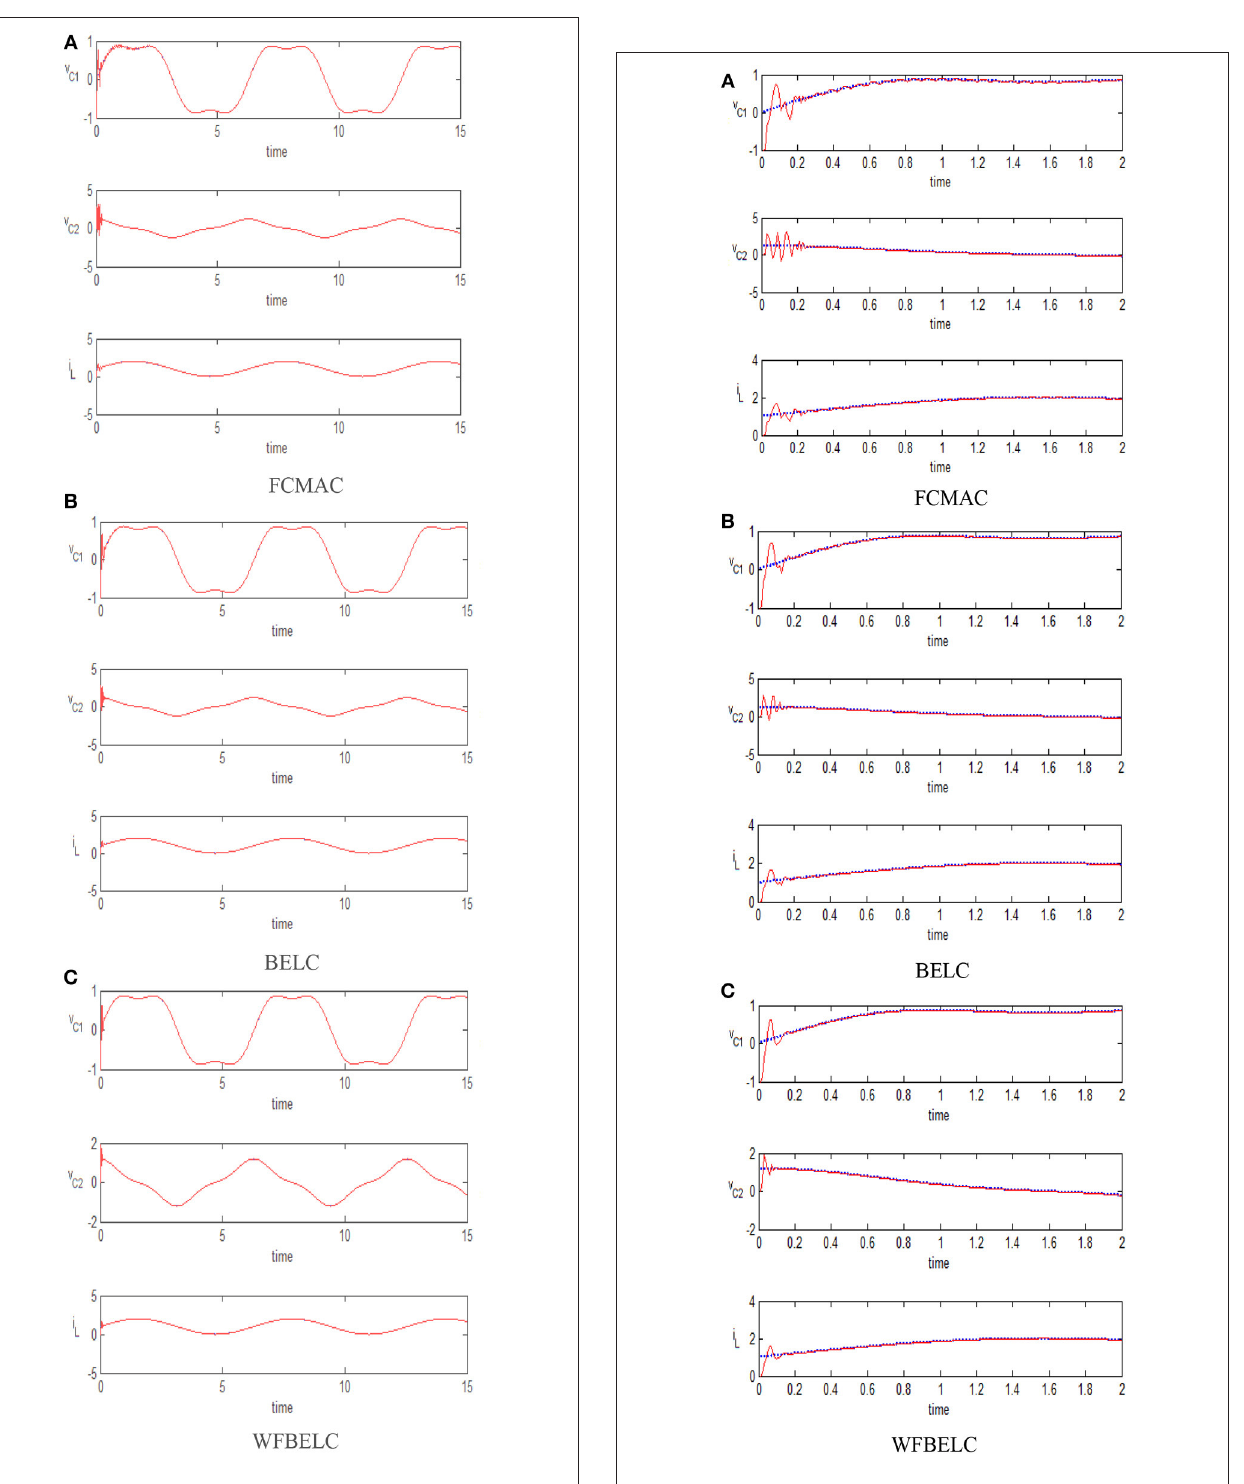
FIGURE 15 | Trajectory responses (A) FCMAC, (B) BELC, and (C) WFBELC. FIGURE 16 | Enlarged responses (A) FCMAC, (B) BELC, and (C)